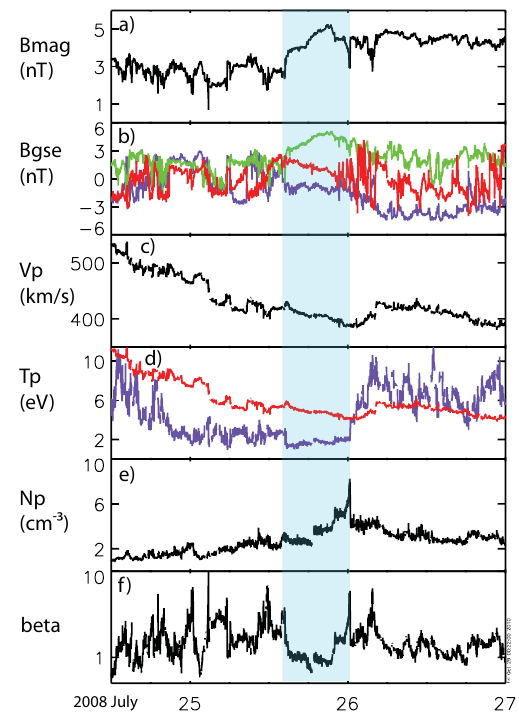
Fig. 1. An ICME (Event SC23/13) identified from the OMNI measurements on 25 July 2008 13:25UT–25 July 2008 23:30UT. The blue-shaded area shows the interval of the ICME. The pan- els show: (a) magnetic field magnitude, (b) magnetic field compo- nents in GSE coordinates (blue: B X , green: B Y , red: B Z ), (c) solar wind speed (d) solar wind proton temperature (blue) and T ex (red), (e) proton density, and (f) proton